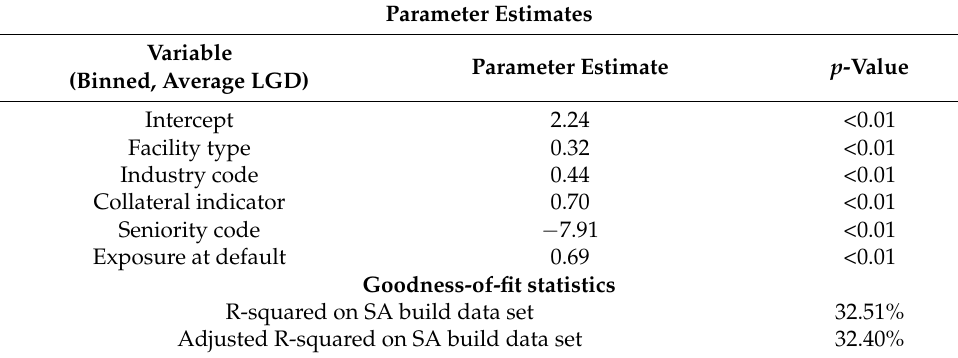
Table 7. Regression results of the build data set of the SA GCD LGD.